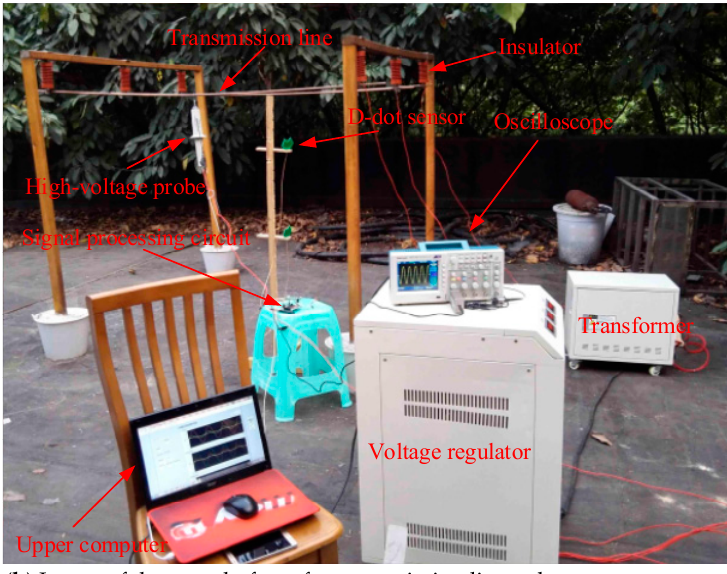
Figure 9. Experimental platform for the voltage measurement of the transmission line.